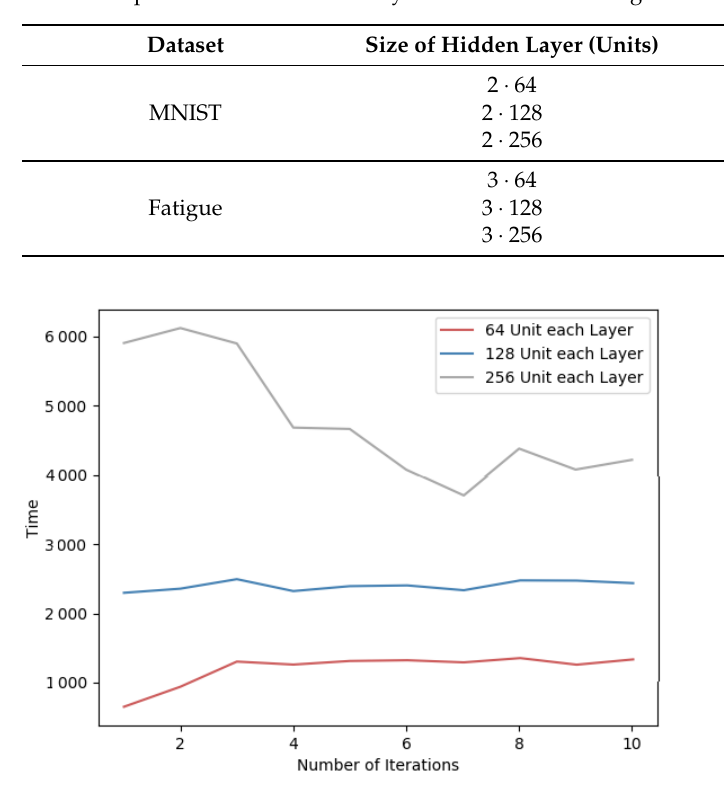
Table 7. Impact of different hidden layer sizes on total training time.